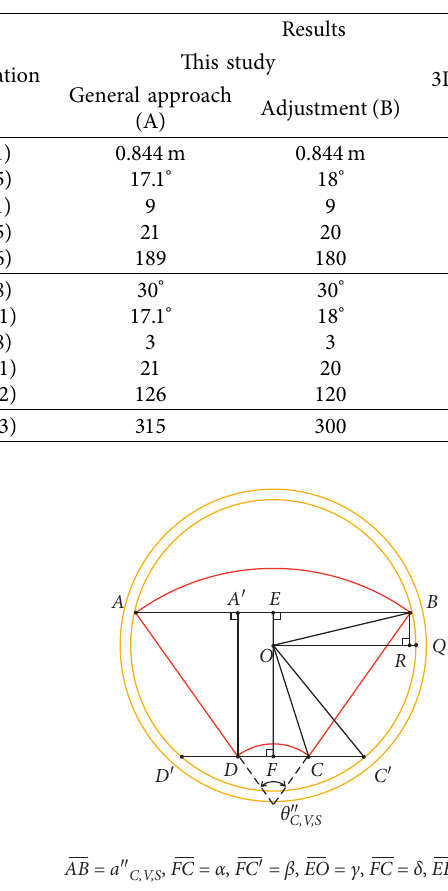
Table 1: Segmentation strategy derived for the spherocylinder-type object assumed in this study and comparison with the results from 3D modeling using Rhino [15].